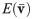
Reprinted from [Fig 11] under a CC BY license, with permission from [SUTC], original copyright [2018].Distribution of total system emissions in Lasa. Fig 11 (A) displays E(v¯) without tolls (g/h), and Fig 11 (B) displays E(v^) with differentiable tolls (g/h).